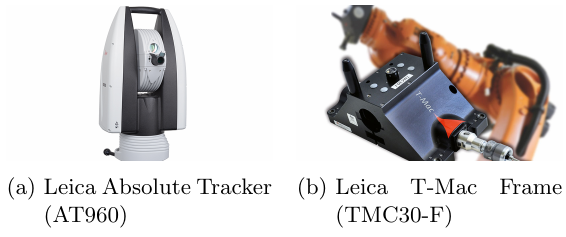
Figure 4: Leica 6-DOF measurement system (Hexagon Manufacturing Intelligence,